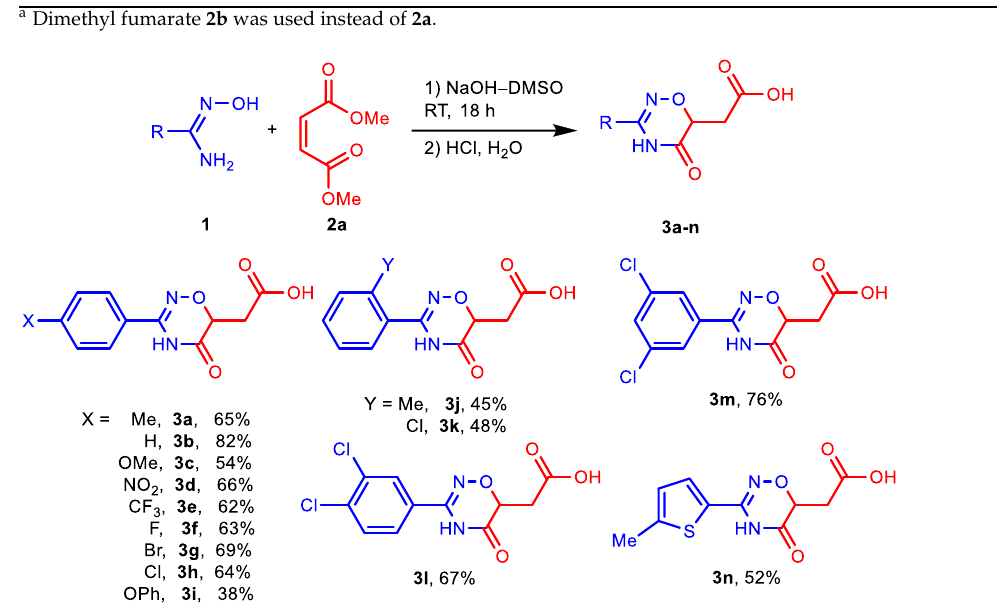
Scheme 2. Reaction of amidoximes 1 with 2a in NaOH – DMSO medium. Reaction conditions: 1 (2 mmol), 2 (4 mmol), NaOH (4 mmol), DMSO (3 mL), RT, 18 h. Isolated yields are presented.